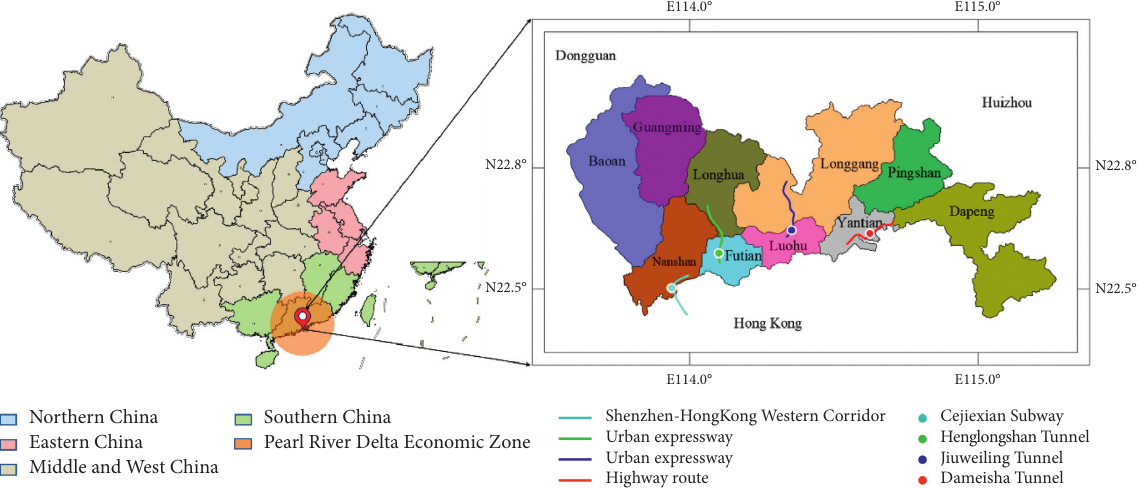
Figure 1: The study area and case tunnel locations.